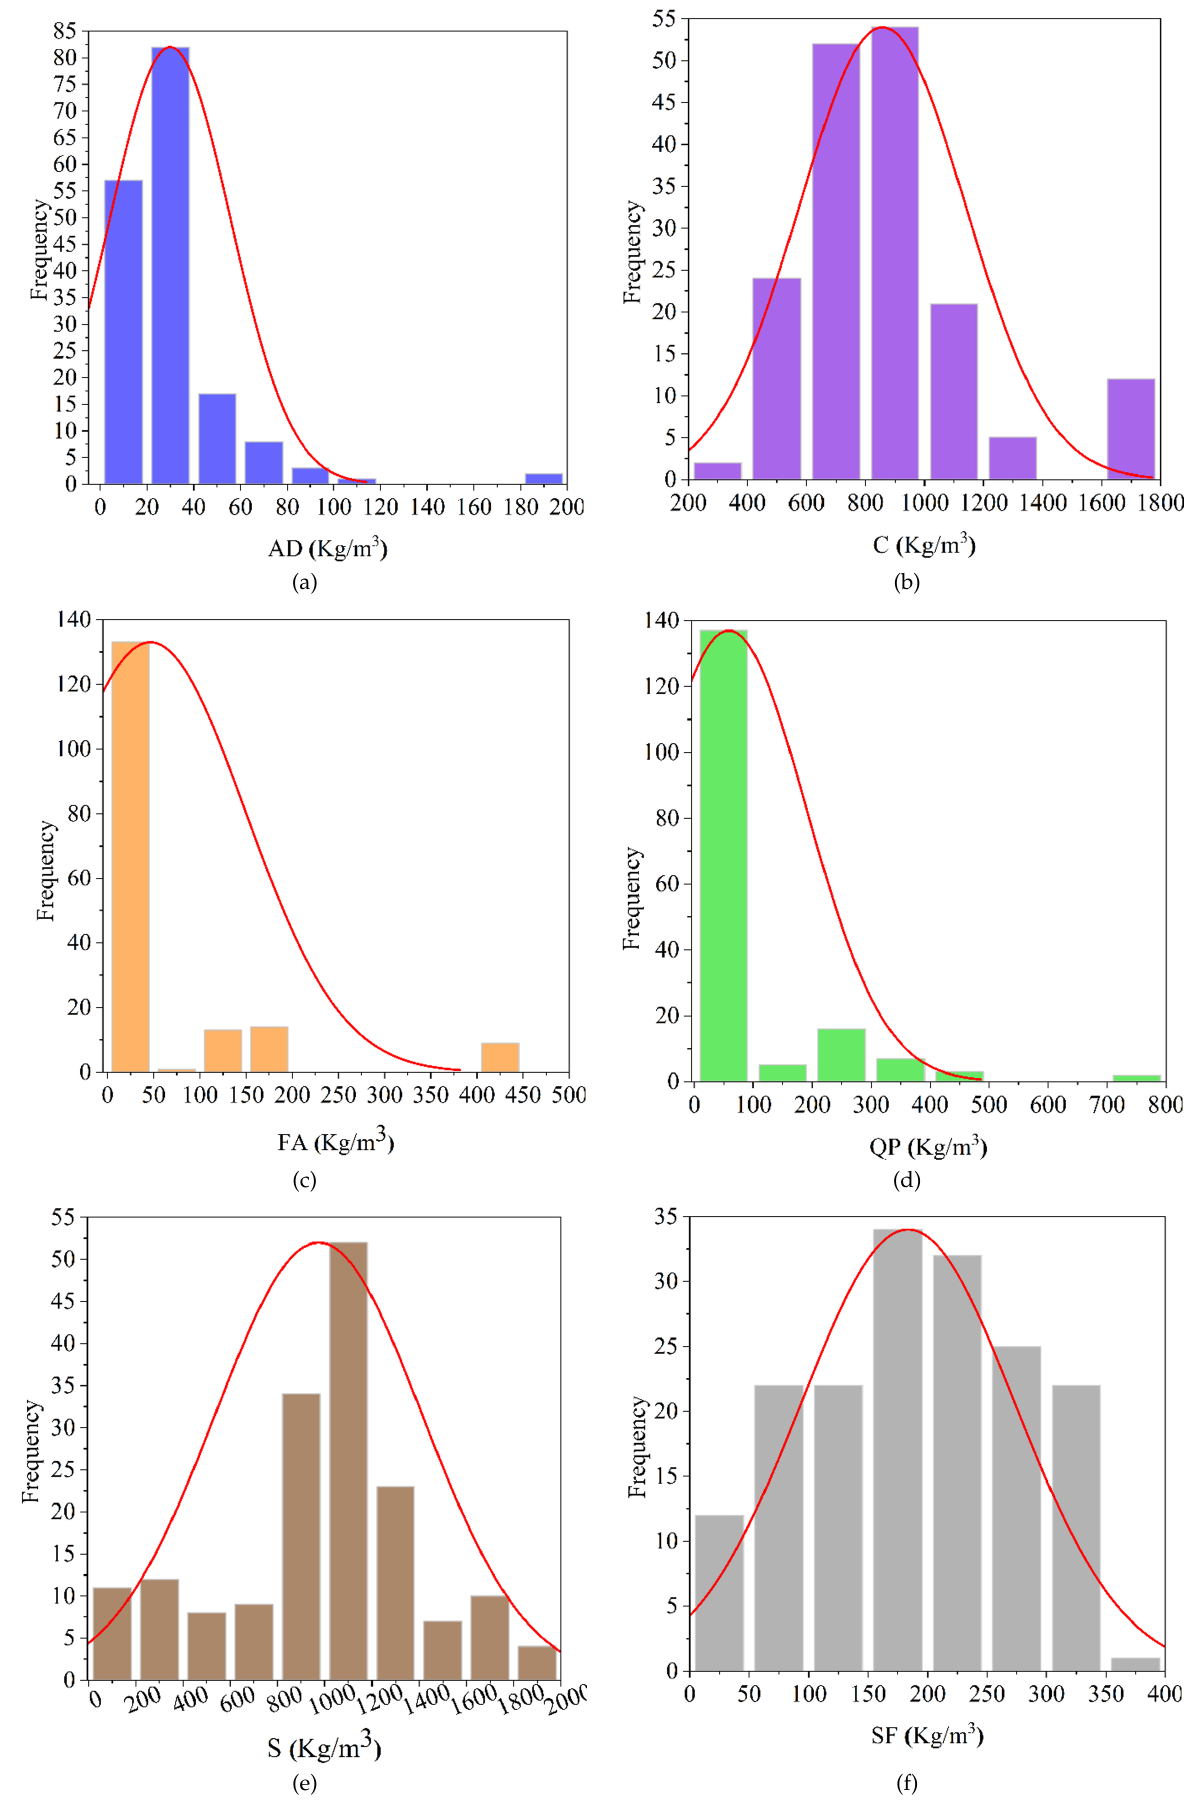
Fig. 1. Distribution of input